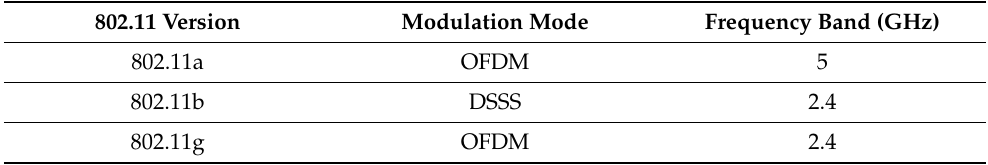
Table 1. A list of several typical 802.11